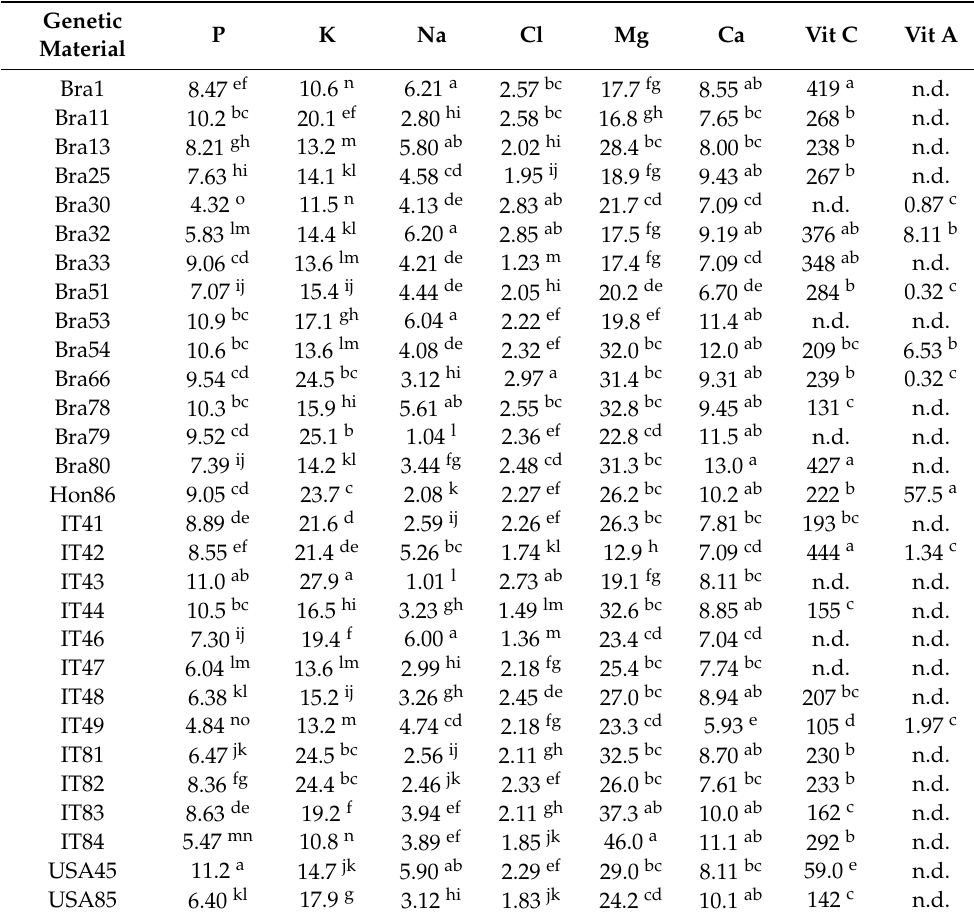
Within each parameter, values without common letters significantly differed at p < 0.05 according to Tukey’s HSD test. n.d = not detected.